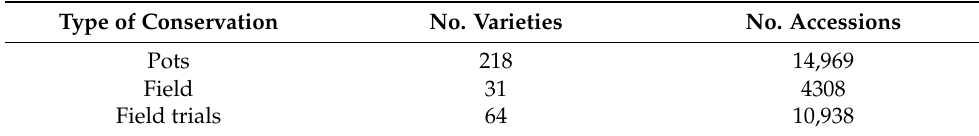
Table 1. Types of conservation of the intra-varietal diversity of varieties in Portugal.